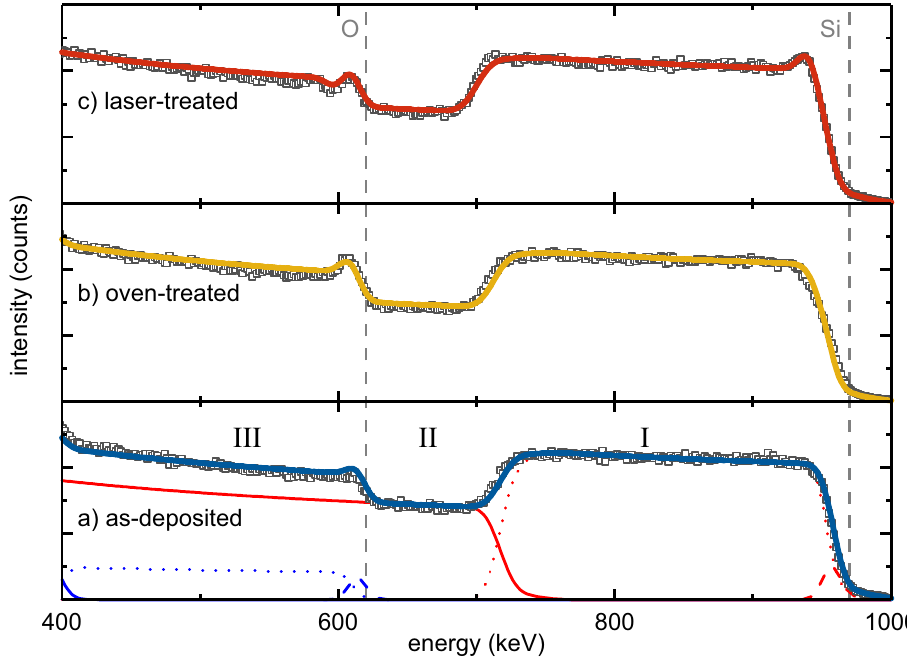
Figure 1. Rutherford backscattering spectrometry (RBS) spectra of SiO 0.6 layers on SiO 2 : as-deposited ( a ), after conventional oven ( b ) and after laser treatment ( c ). The energy range between 1keV and 1.7keV, which shows traces of Ar and W, was omitted for clarity. Squares represent measured data and lines fitted curves. In ( a ), single-layer elemental profiles are additionally shown, i.e., red for Si and blue for O. The roman letters (I, II, III) indicate the major RBS feature types explained in the